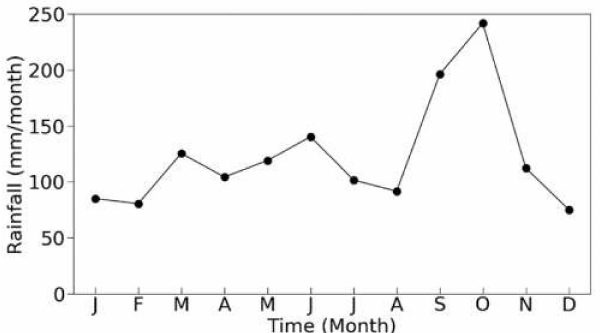
Figure 8. Monthly averaged amounts of